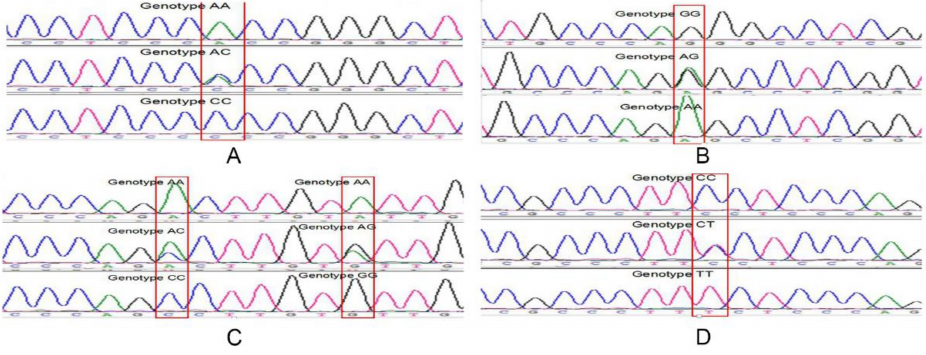
Figure 6. Sequence variants of the STAT3 promoter. Annotations A, B, C, and D represent the five SNP sites and the resultant